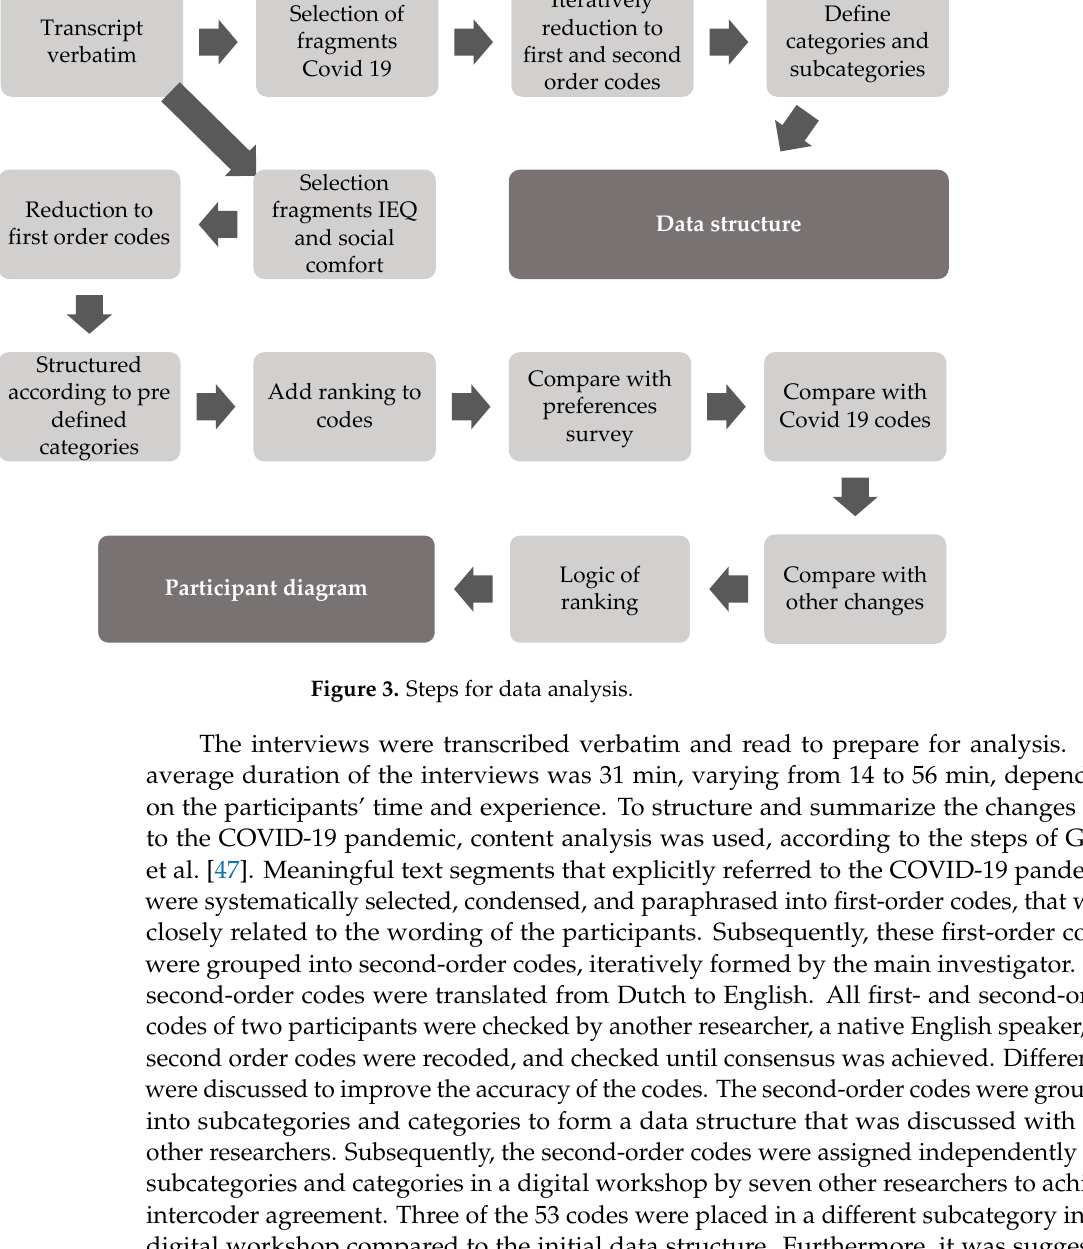
Figure 4. Flow diagram of recruitment. * inclusive participants that were not within the inclusion criteria or canceled.